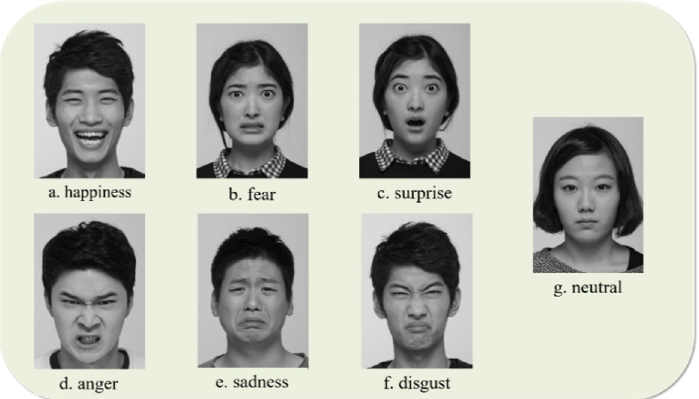
Figure 1. The facial stimuli representing the six basic emotions and the neutral emotion, adapted